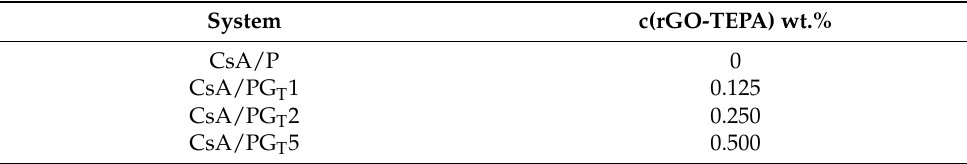
Table 1. The composition of all electrospun nanofibrous